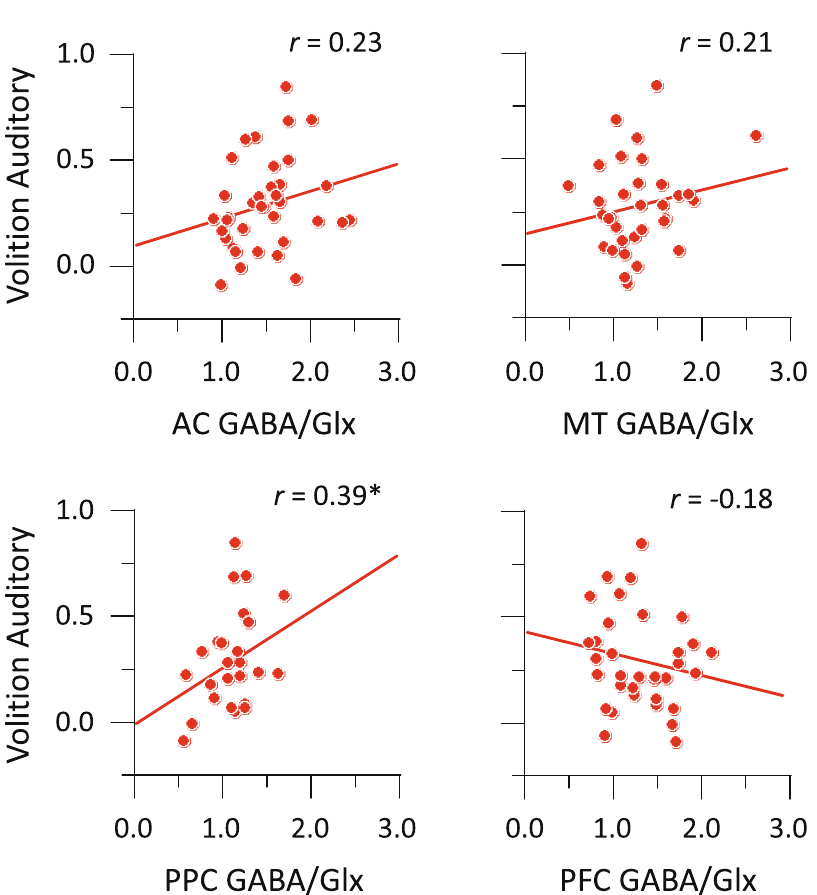
Figure 6. Correlations between MRS measure and volitional control for auditory streaming. Amounts of effective volitional control as a function of GABA/Glx ratio. * p <